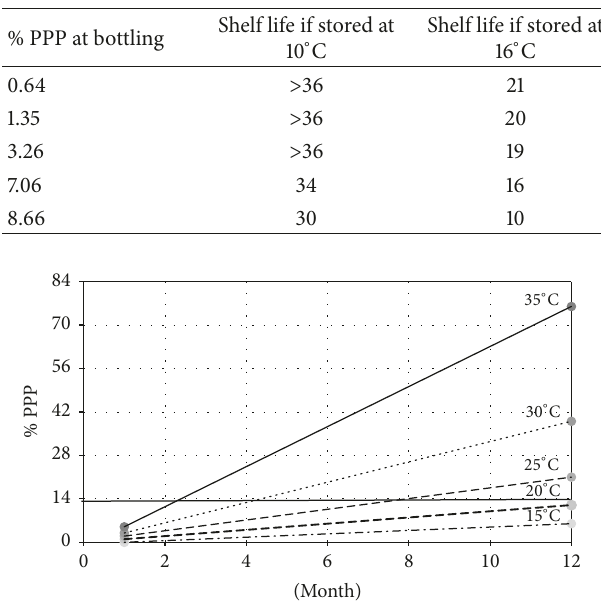
Figure 4: Predicted % PPP during one year of storage at temper- atures between 15 ∘ C and 35 ∘ C { adopted from Aparicio-Ruiz et al. (2012) [16] }